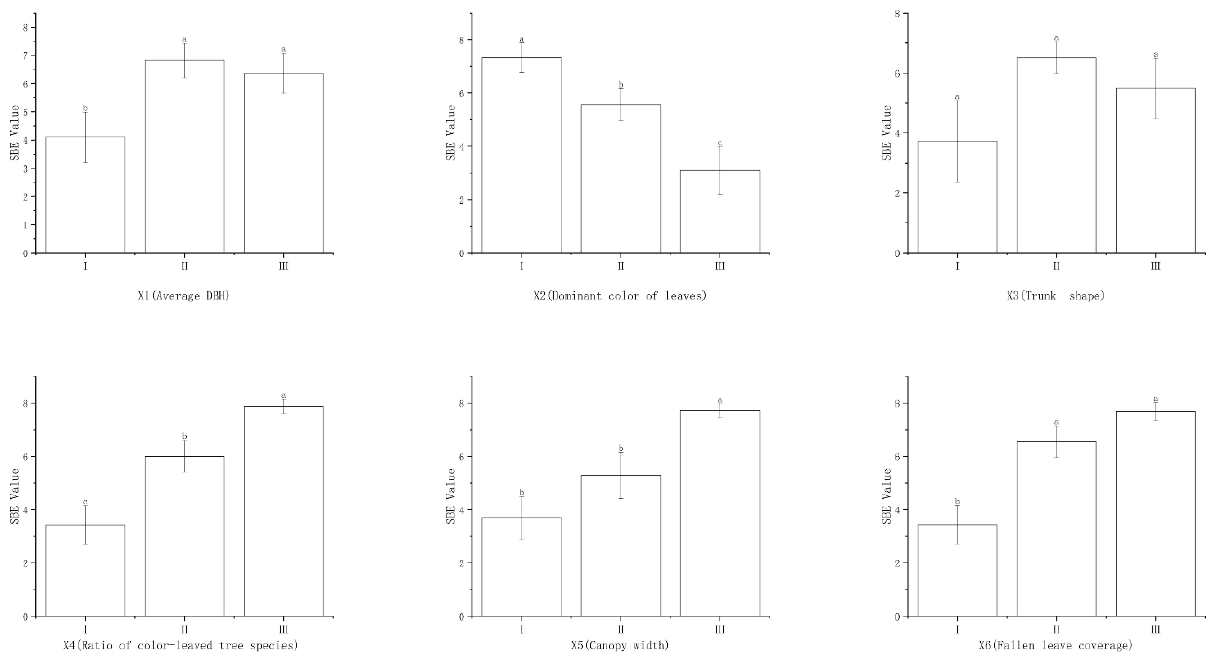
Figure 6. Relationships between landscape elements’ grades and SBE from the ground perspective. (When a and b or a, b, and c symbols appeared in different landscape element classes, the difference is significant or highly significant; if both are a, the difference is not significant.)